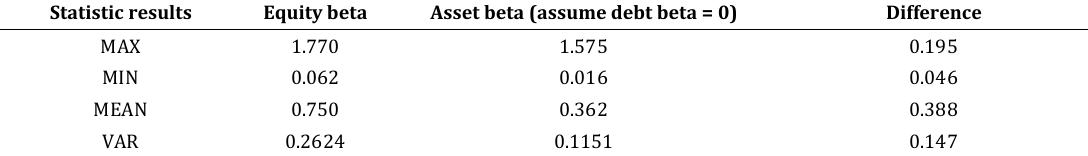
Table 6: Statistical results (tax rate =